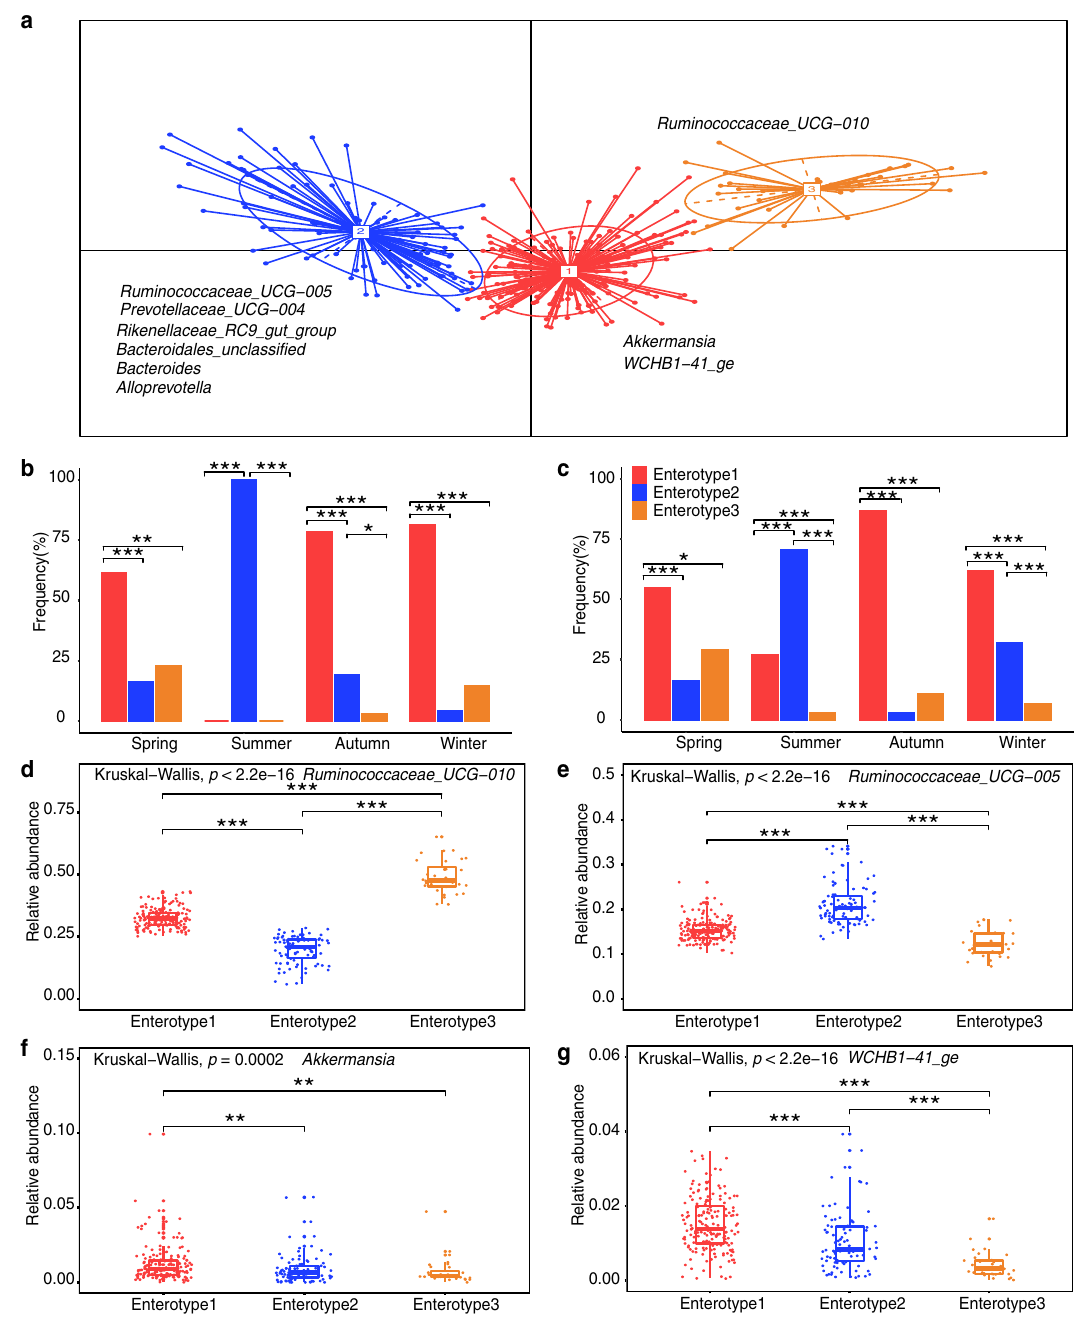
Fig. 7 Enterotype distributions of yak gut microbiota associated with season using Bray – Curtis dissimilarity. Identi fi cation of yak enterotypes is presented in Supplementary Fig. 9. a Visualizations of enterotypes, as identi fi ed by PAM (partitioning around medoid) clustering. Genera corresponding to each enterotype are identi fi ed by their relative abundance (see Supplementary Fig. 10). b and c Proportion of samples for each enterotype in spring, summer, autumn, and winter in ( b ) transhumance and ( c ) open-continuous grazing regimes. d – g Relative abundance of bacterial taxa characteristic of each enterotype. Ten genera were chosen based on their average contribution to overall Bray – Curtis dissimilarity. All six bacterial genera are presented in Supplementary Fig. 10. Colors correspond to enterotype clusters. All bar distributions are tested by Fisher ’ s exact test with FDR (false discovery rate) corrected two-tailed p -values ( b and c ). All boxplot distributions are tested by non-parametric Kruskal – Wallis and Wilcoxon with FDR-corrected p -value, center values indicated the median and error bars ( d – g ). * p < 0.05, ** p < 0.01, *** p <